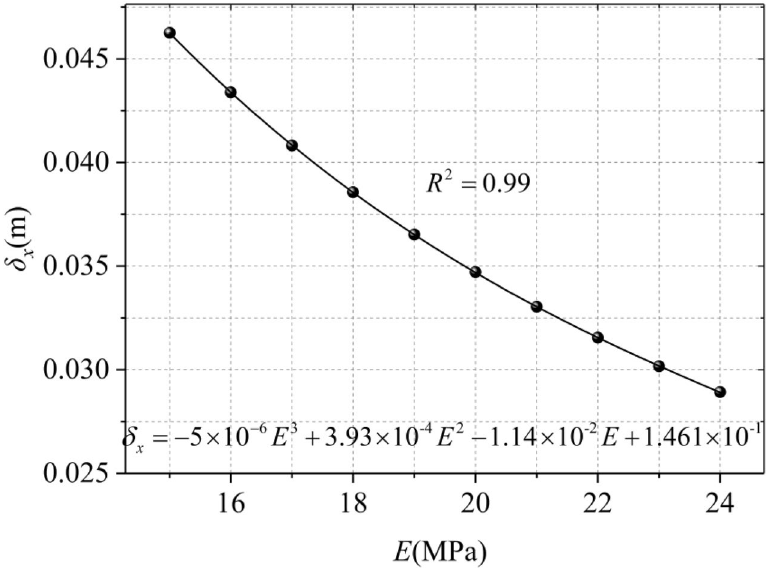
Figure 6. Maximum horizontal displacement with different elastic modulus.